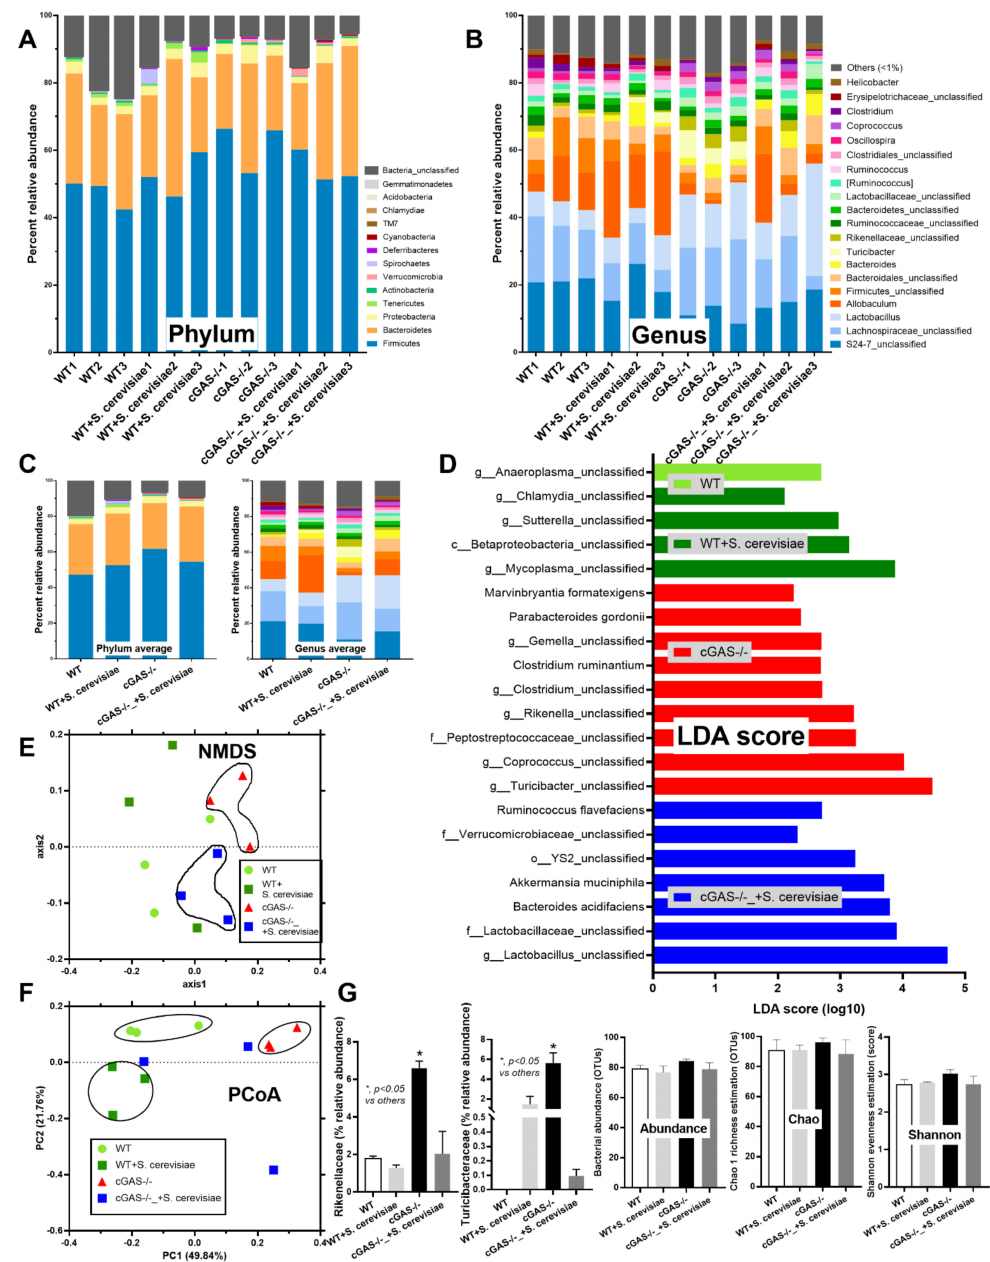
Figure 2. Fecal microbiome analysis from azoxymethane (AOM) with dextran sulfate solution (DSS)- induced colon cancer and oral gavage of phosphate buffer solution (PBS) control or Saccharomyces cerevisiae ( S. cerevisiae ) in cGAS-deficient (cGAS-/-) and wild-type (WT) mice as indicated by the abundance of fecal bacteria in phylum and genus level with the average value ( A – C ); the possible unique bacteria in each group using linear discriminant analysis (LDA score) ( D ); the dissimilarity among each group by distance from the axis with non-metric multidimensional scaling (NMDS) ( E ); the principal coordinate analysis (PCoA) of the community structure using ThetaYC distances ( F ); and a graph demonstration of significant bacteria, with the total bacterial abundance in operational taxonomic units (OTUs) and alpha-diversity analysis (Chao-1 and Shannon score) ( n = 3/group). *, p < 0.05 vs. other groups. The analysis of multiple groups ( G ) were determined by one-way analysis of variance (ANOVA) with Tukey’s analysis. The exact p values were demonstrated in Table